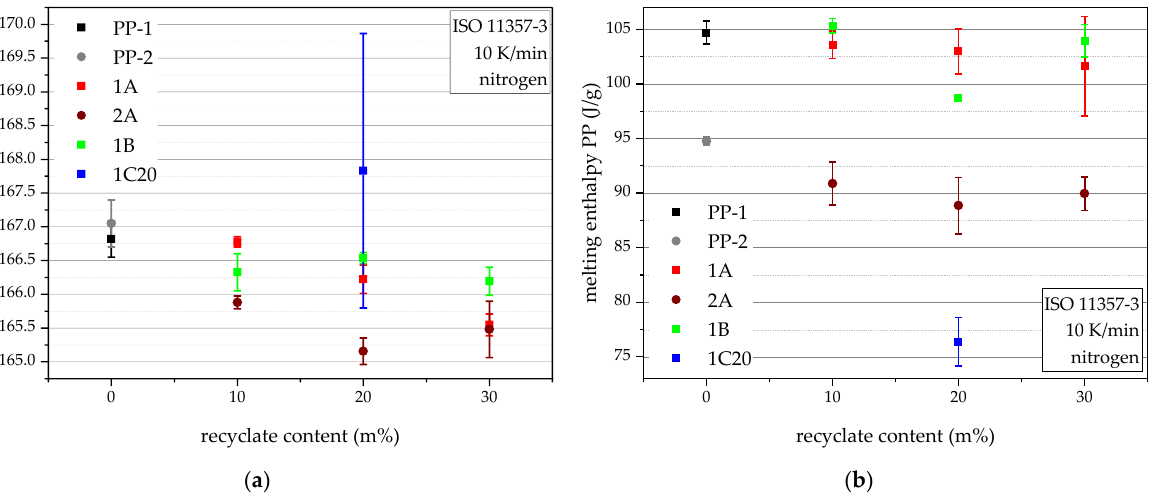
Figure 5. DSC results of the virgin blending partners and all compounds in terms of PP melting tem- peratures ( a ) and PP melting enthalpies ( b ). The vertical bars show the sample standard deviations.